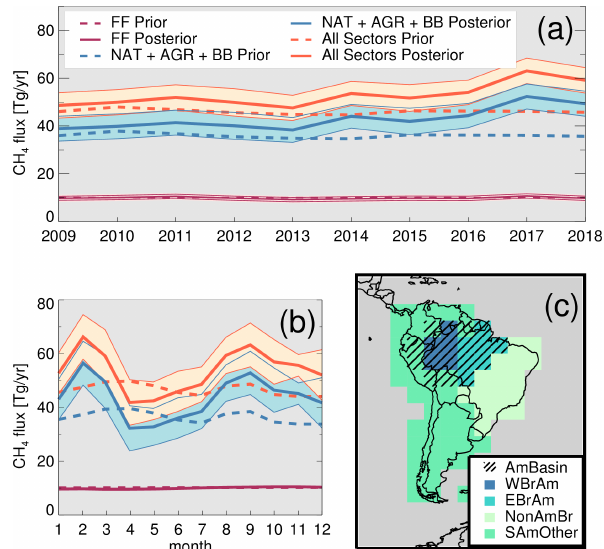
Figure 4. (a) Total annual Brazilian prior and posterior emissions (Tg(CH 4 ) /yr). Shaded areas show posterior uncertainties as derived in the inversion. (b) Monthly mean prior and posterior Brazilian CH 4 emissions (Tg(CH 4 ) /yr, 2009–2018). Shaded areas show the standard deviation for each month. (c) Regions of South America discussed in the text. The hatched area (AmBasin) represents the Amazon basin across all countries, whilst the shaded areas show Brazilian and non-Brazilian